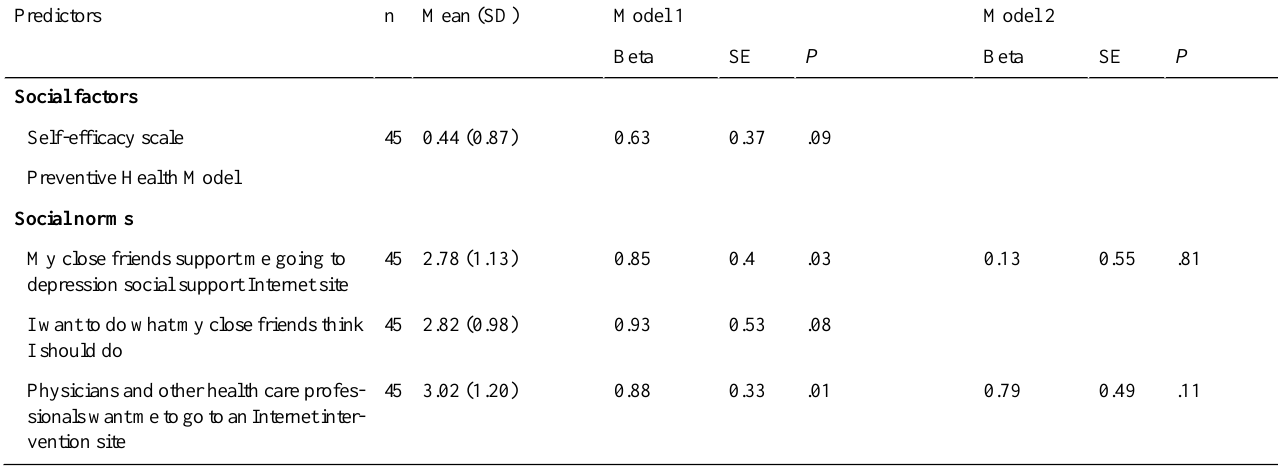
Table 7. Predictors of posts viewed reporting only with P <.10. a